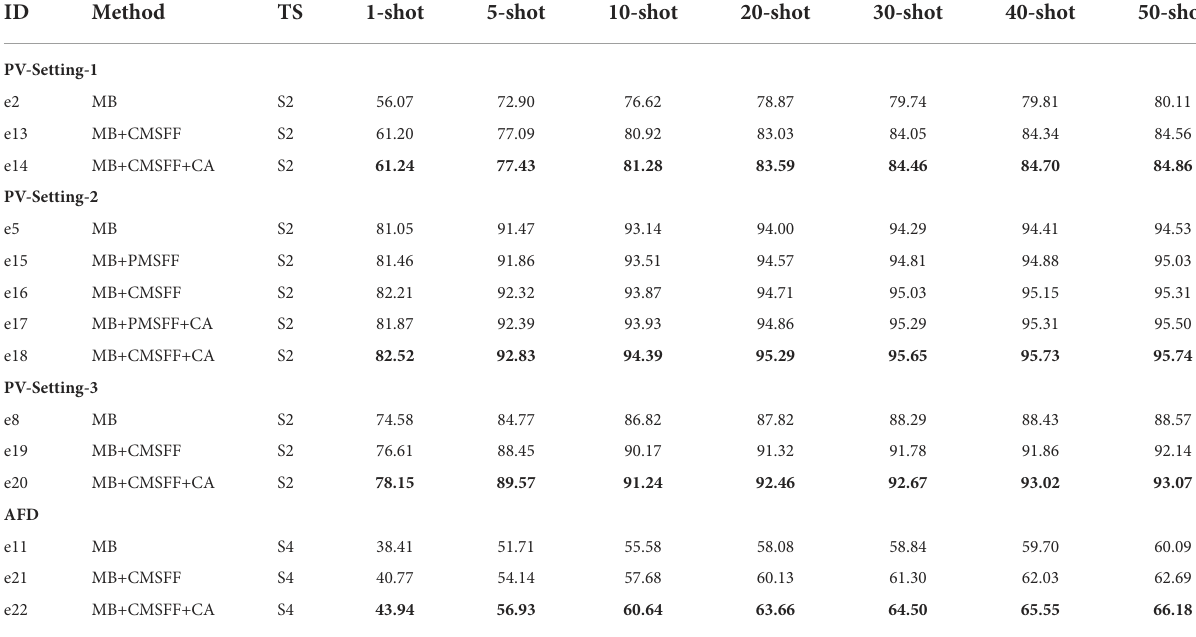
TABLE 5 The ablation experiment results of MB, MB+CMSFF, and MB+CMSFF+CA.